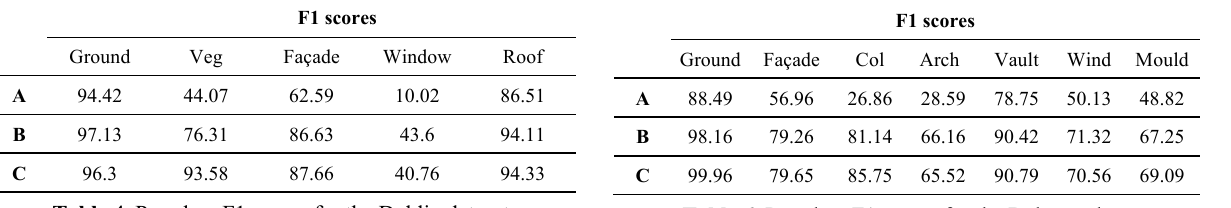
Table 6. Per-class F1 scores for the Bologna dataset.